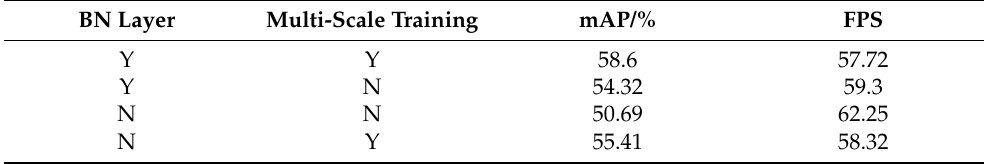
Table 2. Comparison of experimental results of SMYOLO using BN and multi-scale